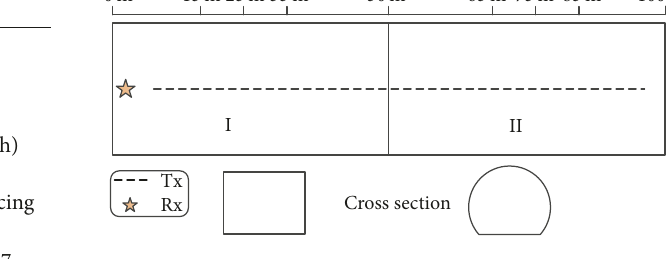
Figure 3: SISO path loss